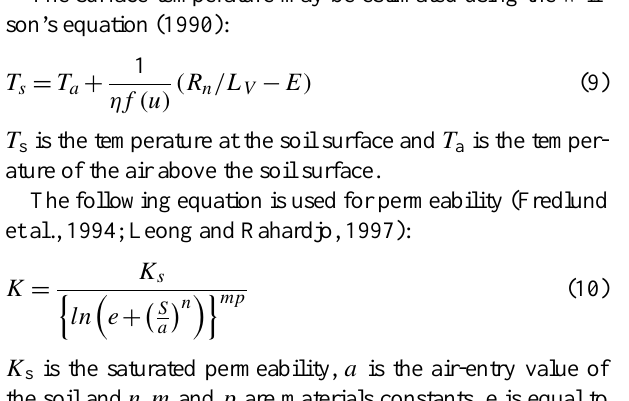
Figure 3b. Verfication of the numerical model on the test of Wilson (1990) - Suction variton